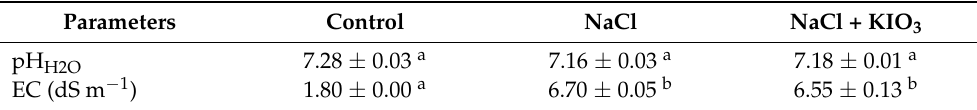
Table 1. pH and electrical conductivity (EC) in soil at the harvesting of control plants, and plants fertilized with nutrient solution added with salt (NaCl) or with salt plus iodine (NaCl + KIO 3 ). Data are means ± SE. Parameters